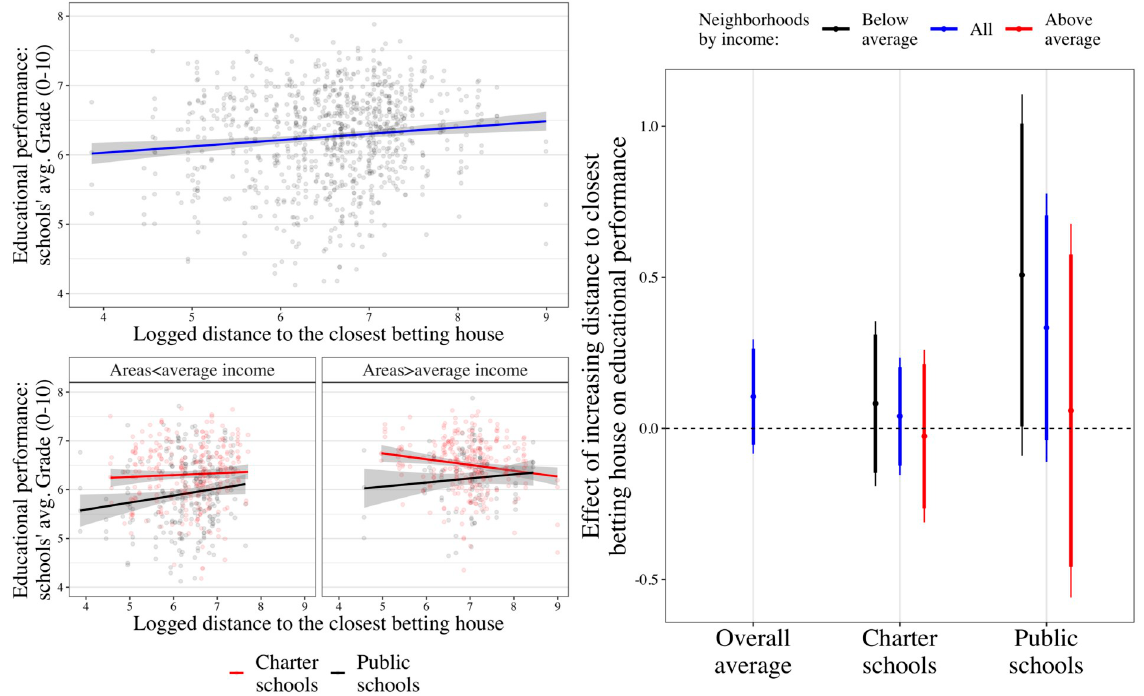
Fig 3. Estimated effect of distance betting houses on educational performance using TWFE estimators. Note: The figure includes three panels. The top-left panel shows the linear association between distance and academic performance. The bottom-left splits the top-left panel into four subgroups by neighborhoods’ income level and type of school. The right-hand side panel shows the TWFE models’ results (following Eq 1) but using a continuous variable of exposure to betting houses—logged meters distance.